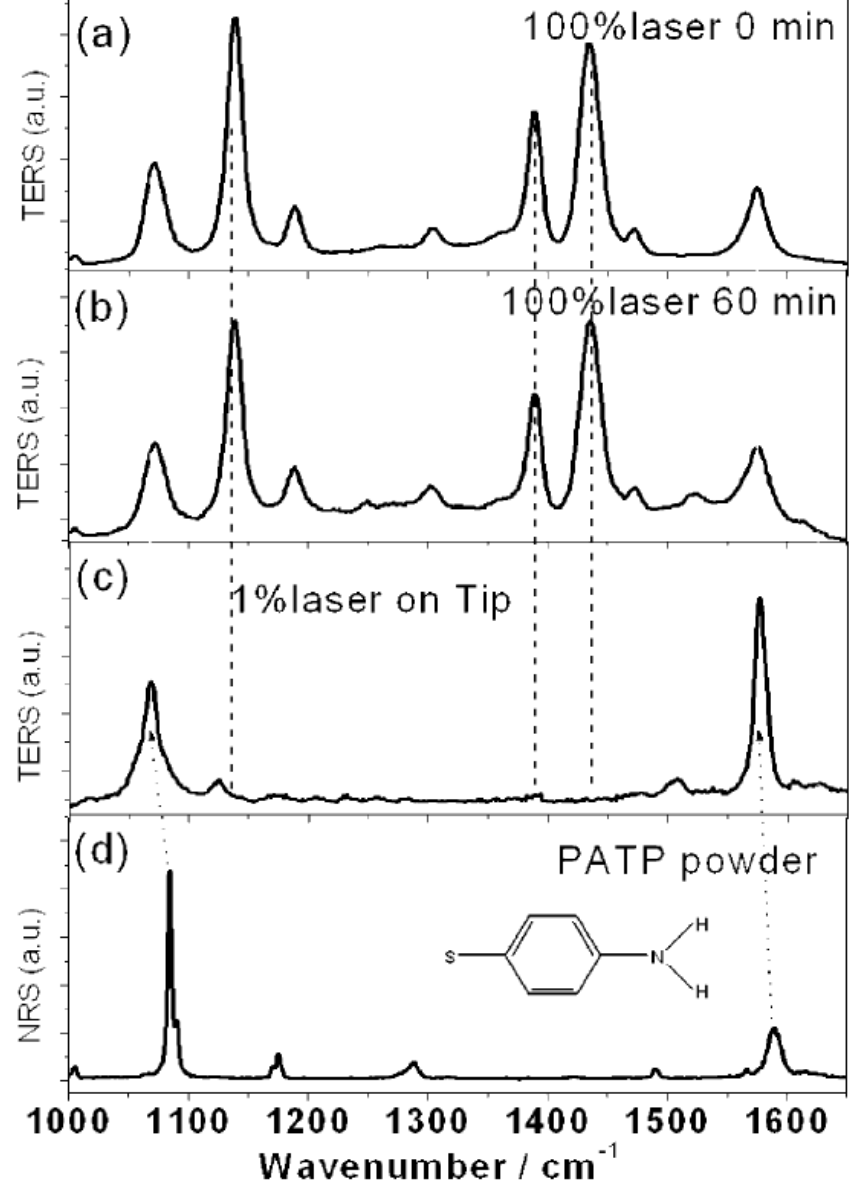
Figure 9. Experimental TER (acidic conditions) and NR spectra. TER spectra of DMAB at ( a ) 0 and ( b ) 60 min. ( c ) TER spectrum on tip with weak excitation after strong excitation for 60 min. ( d ) NRS of PATP powder. Adapted from [11].